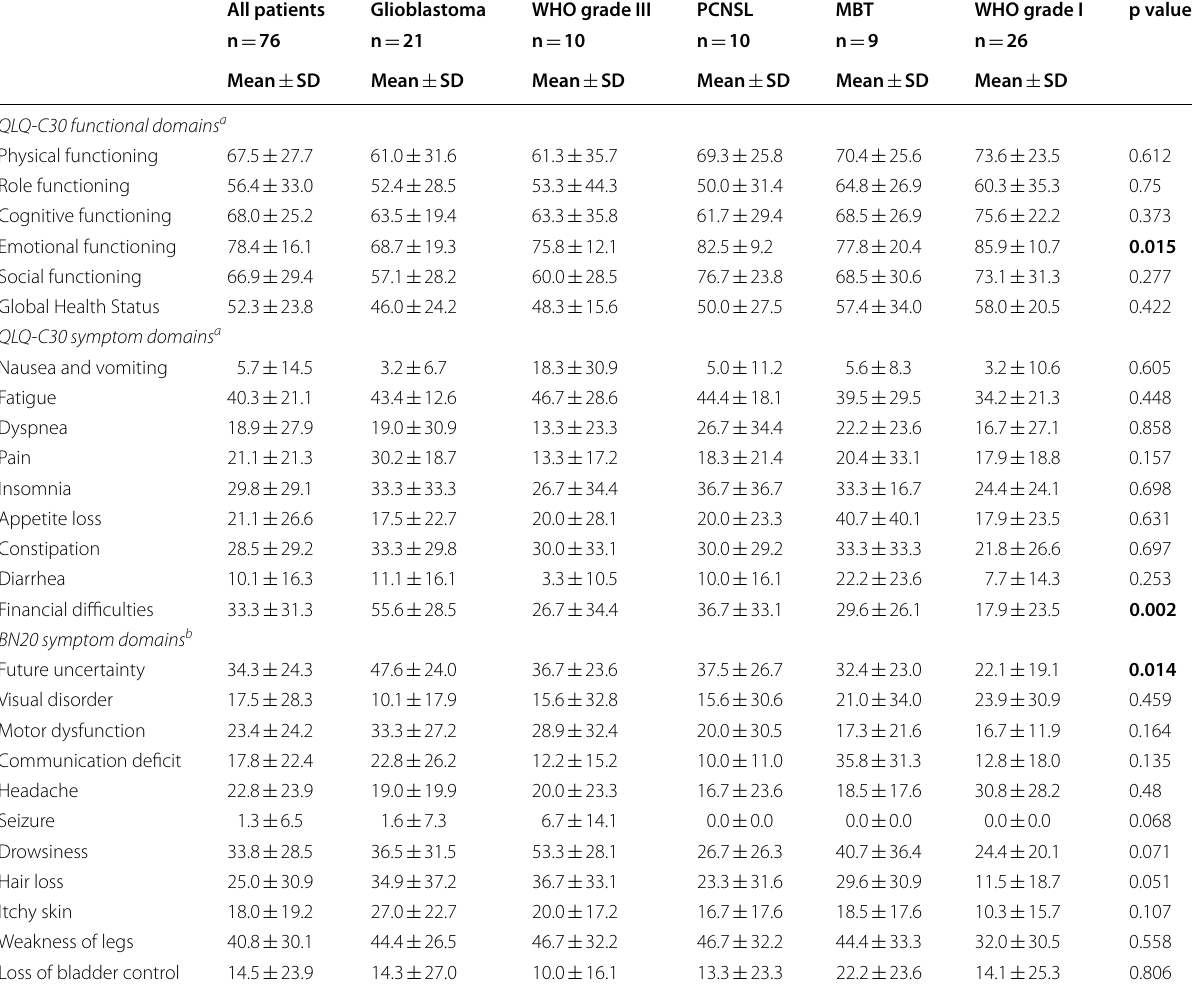
Table 2 Comparison of disease-specific HQOL scale in tumor